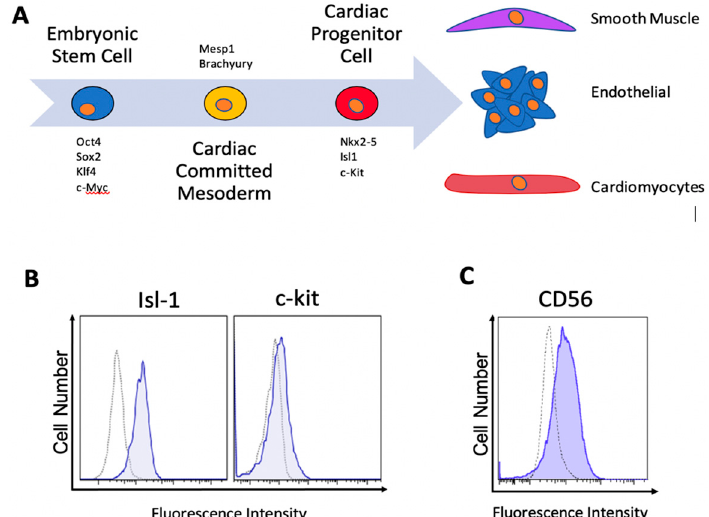
Figure 1. Patient-derived human cardiac progenitor cells (CPCs) can be isolated and selected for expansion as clones that express markers of early stage progenitors. A schematic representation of the cardiovascular differentiation pathway is shown in ( A ). These cells are isolated based on their co-expression of high levels of islet-1 and low levels of c-kit ( B ). Cells at this early stage express the glycoprotein CD56 ( C ).